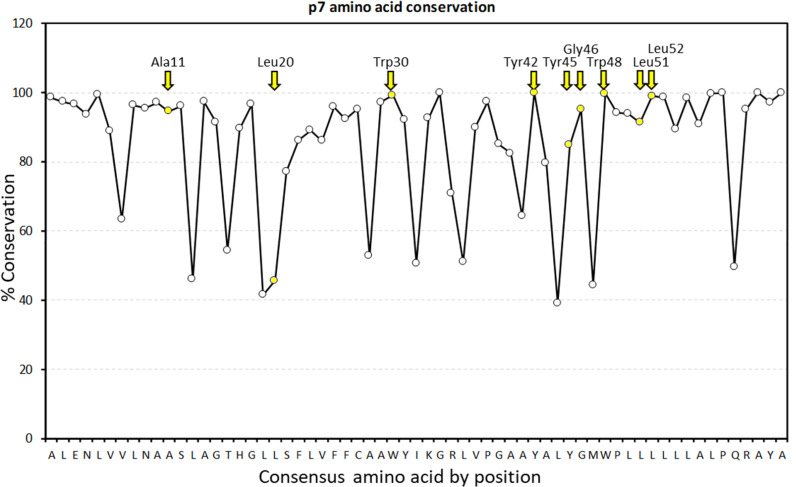
Graphical representation of percentage conservation for consensus p7 sequence (see Figure 2—figure supplement 1—source data 1 for numerical summary).JK3/32 peripheral binding site loci are highlighted in yellow and by yellow named arrows for residues present within the J4 p7 sequence.Figure 2—figure supplement 1—source data 1.Raw data for p7 sequence alignments.